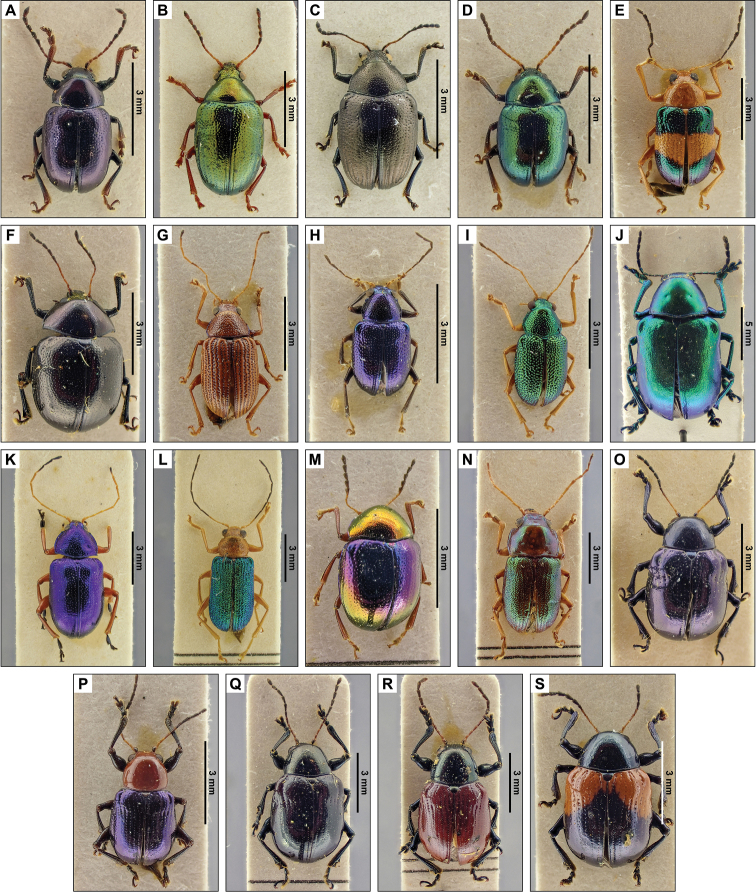
Dorsal pictures of the species of Eumolpinae from El Salvador currently present in the collections of the RBINS. Pictures of nomina nuda spec.s are not depicted. ABrachypnoeacretiferaBB.lateralislateralisCB.lefeivreilefeivreiDB.viridisEChalcophanacinctaFChrysodinopsiscupricepsGColaspisfreyiHC.inconstansIC.lebasiJEumolpusrobustusKNodocolaspisimpressaLPrionoderahirtipennisMSpintherophytacoruscaNTalurusrugosusOTypophoruslimbatusPTypophorusmexicanusQTypophorusnigritusobliquus var. a RTypophorusnigritusobliquus var. b STypophorusnigritusobliquus var. c. High resolution images can be found at http://collections.naturalsciences.be/ssh-entomology.